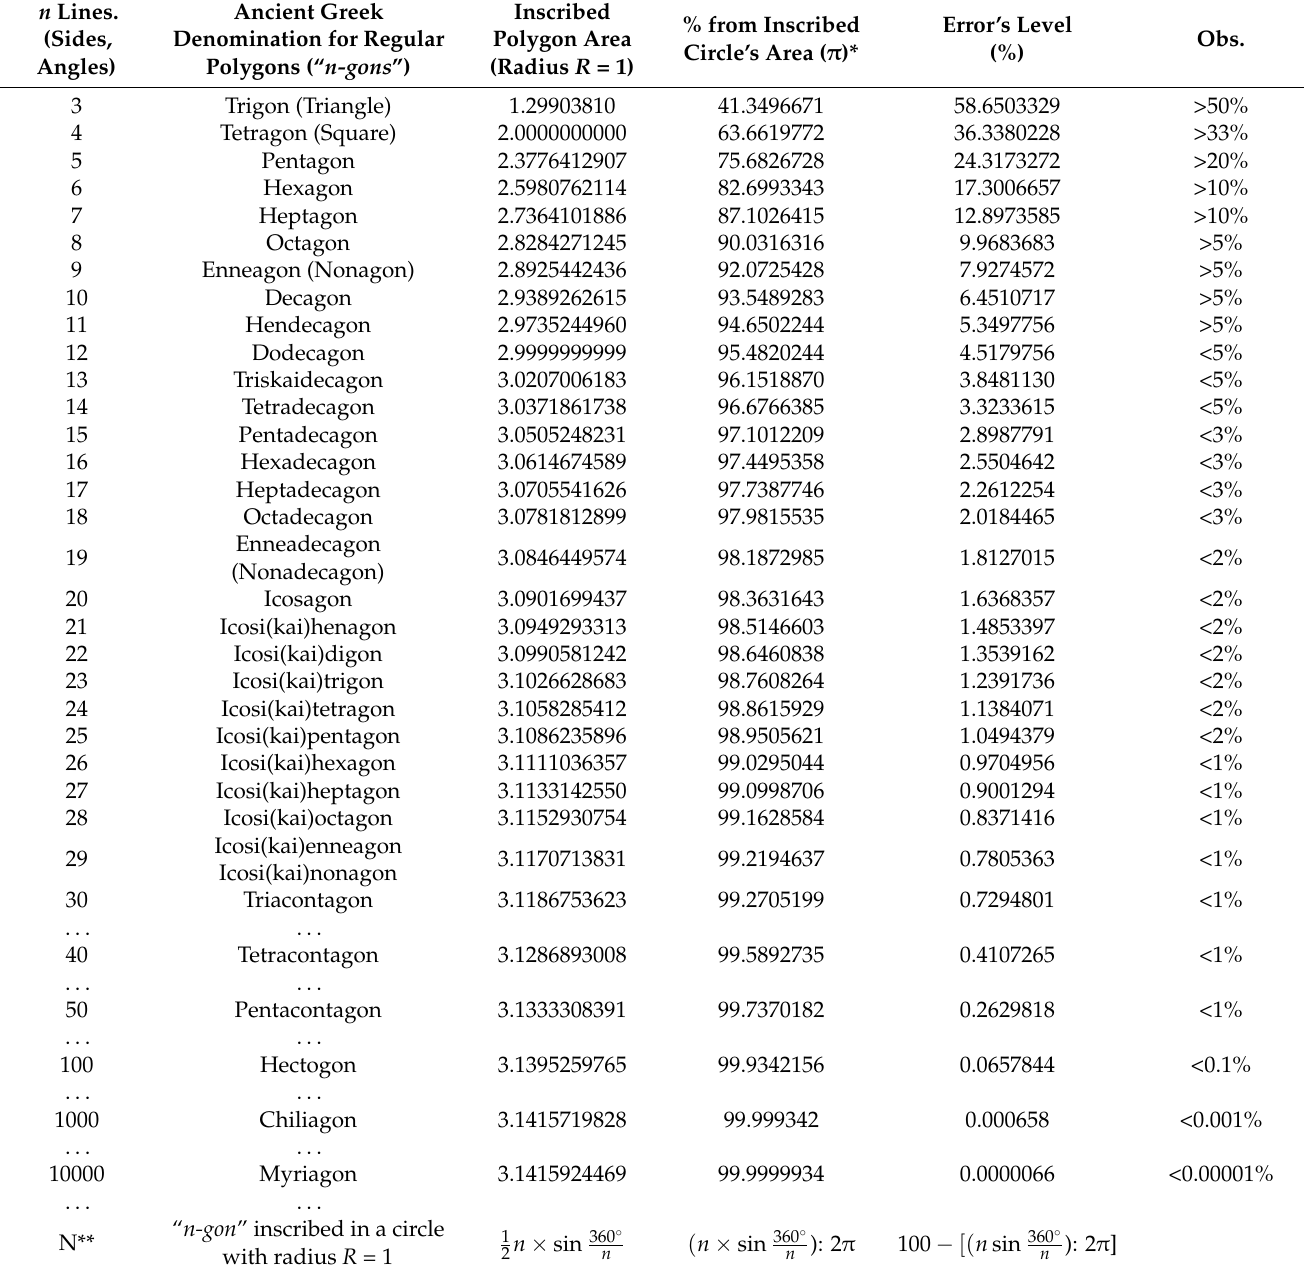
Table 1. A list of “ n-gons ” areas and error’s levels by Greek numerical prefixes. n